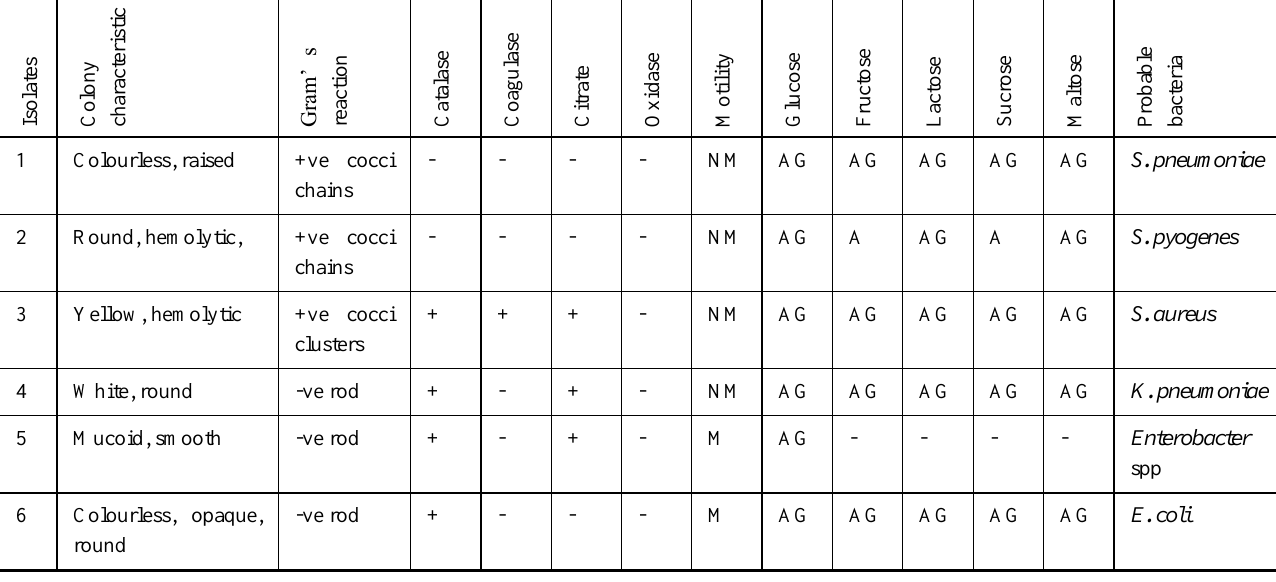
Table 1. Biochemical characteristics of isolates from throat samples.